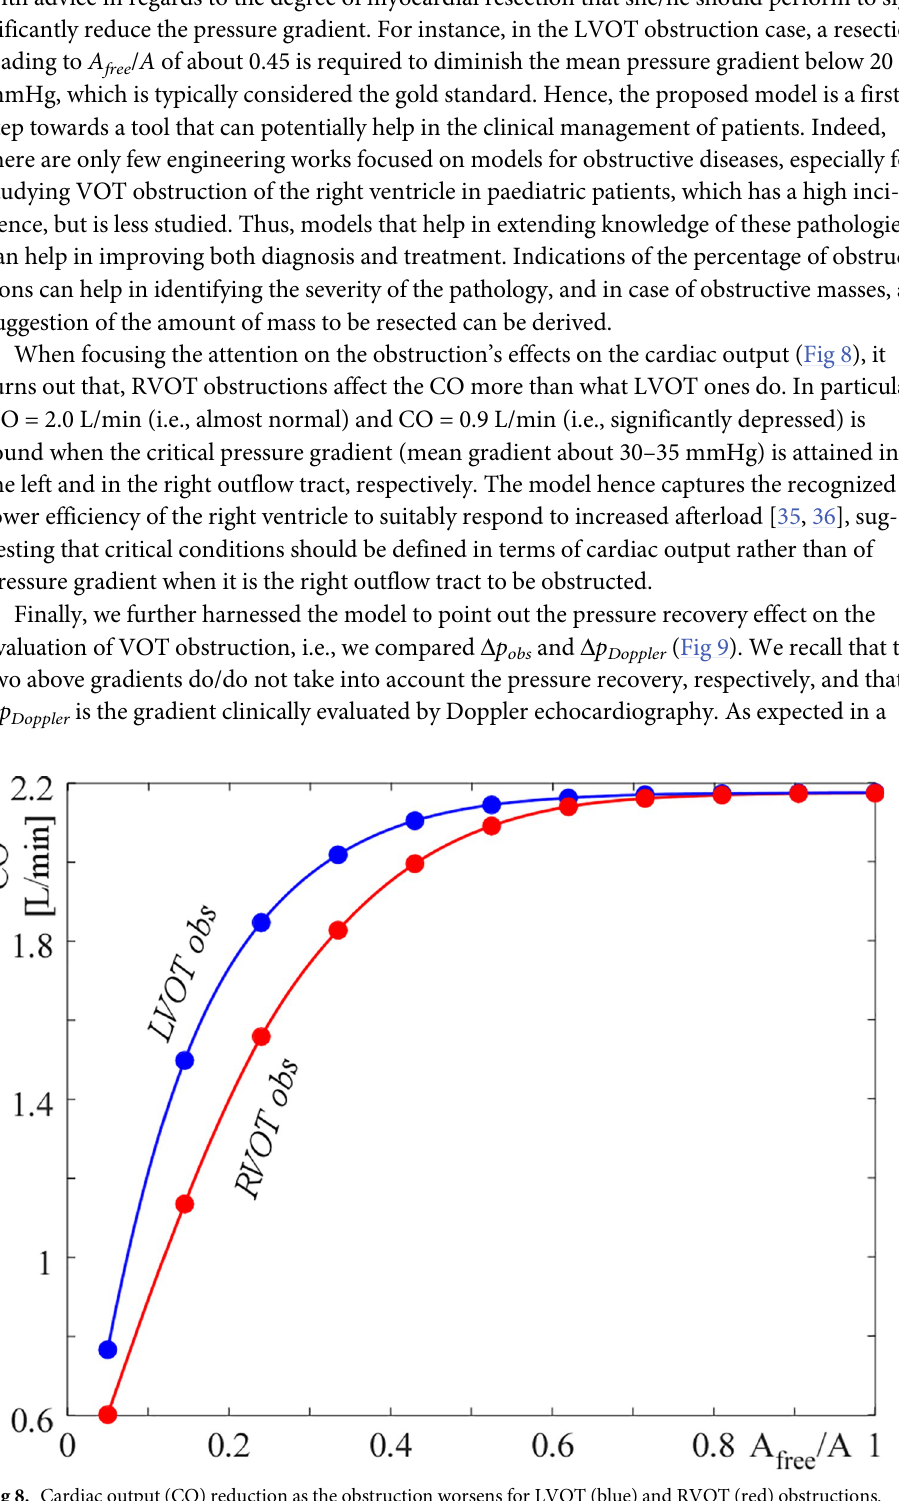
Fig 8. Cardiac output (CO) reduction as the obstruction worsens for LVOT (blue) and RVOT (red)